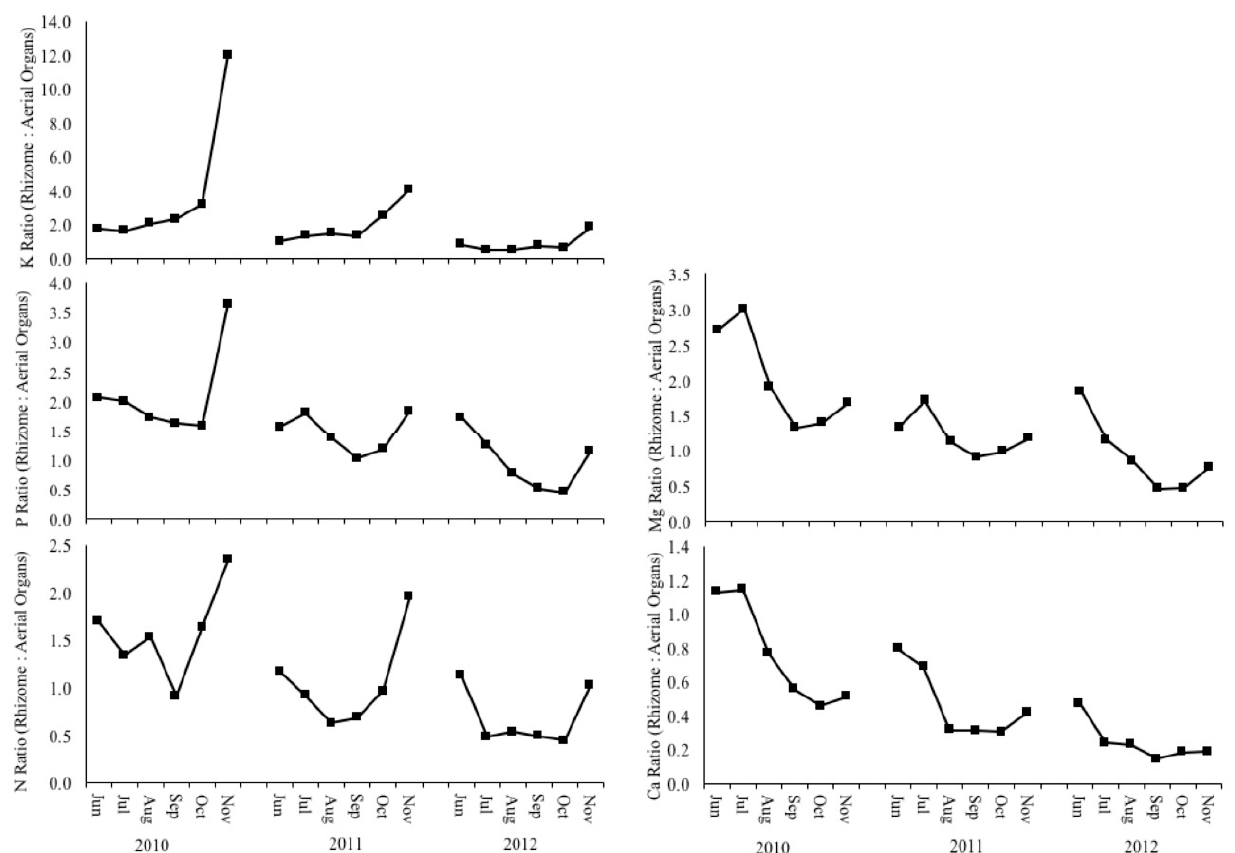
Figure 6. Rhizome: Aerial organ ratio of N, P, K, Ca and Mg in the M. × giganteus biomass in years 2010–2012.